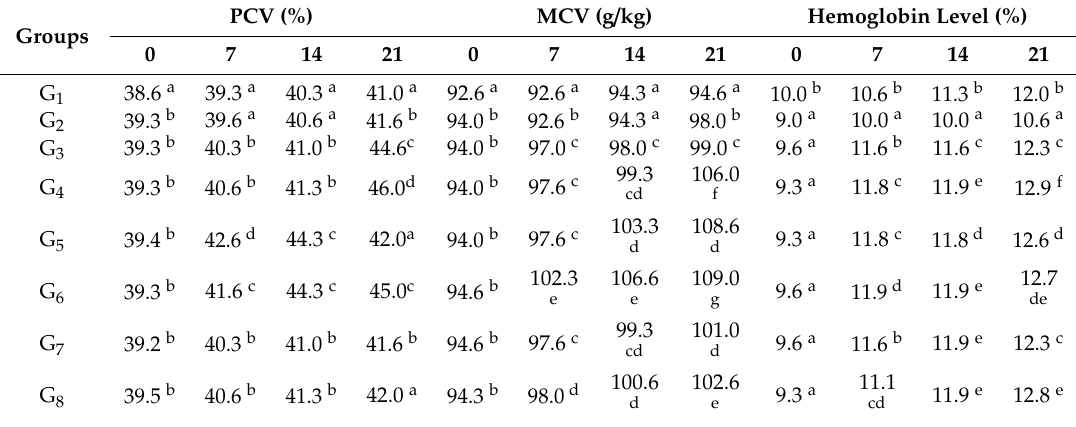
Table 3. Packed cell volume (PCV), mean corpuscular volume (MCV) and the hemoglobin levels of diabetic and control mice fed with di ff erent concentrations of polyphenol extract of guava leaves, pulp and